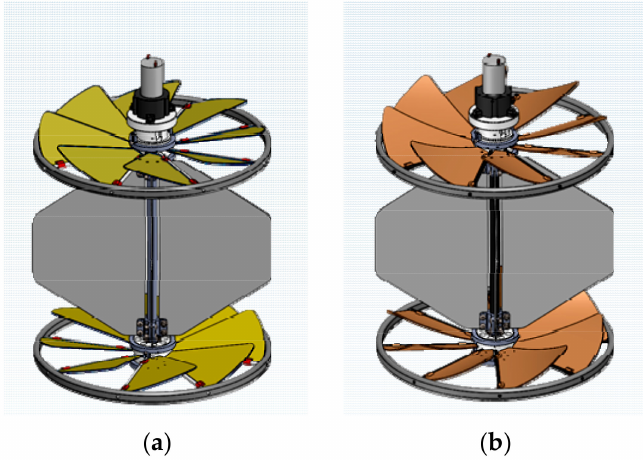
Figure 6. Comparison of conceptual design of the two WEC: ( a ) Rigid blade WEC; ( b ) Flexible blade WEC.